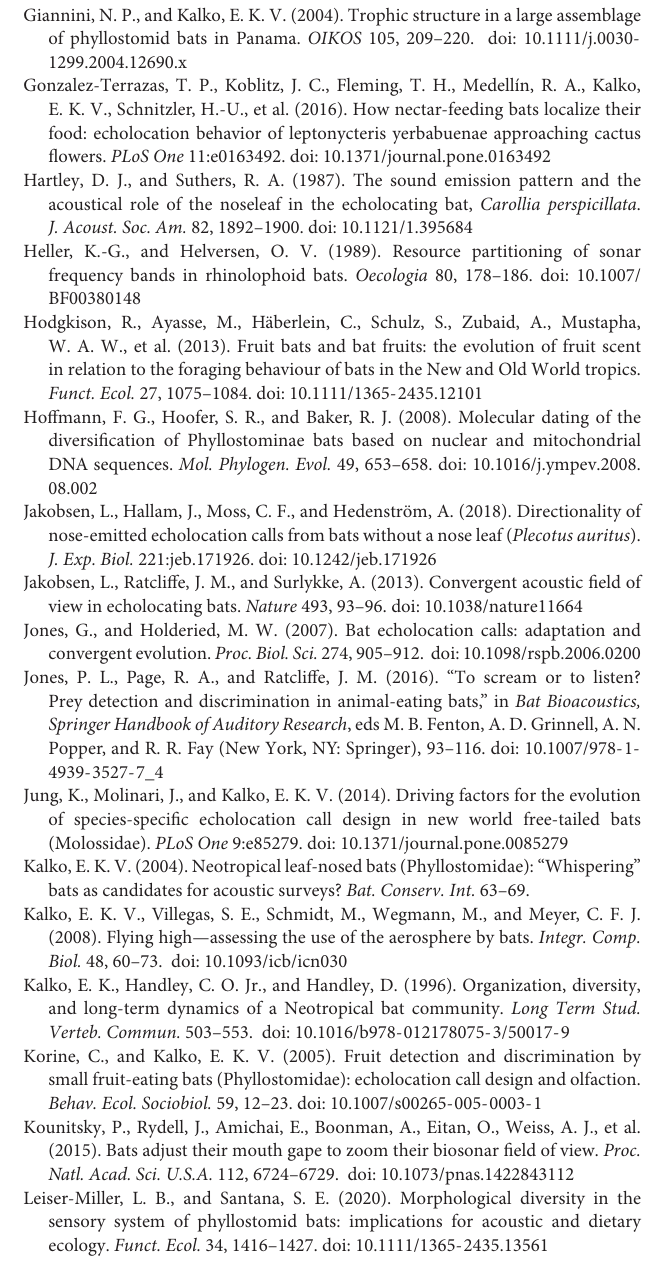
of the bat, infrared lights (IR) and high-speed cagmera (camera) located at ca. 30 cm at a 90 ◦ angle on a parallel line at ca. 40 cm distance to point of release. Supplementary Figure 2 | Schematic drawings illustrating the measured angles: (A) two axes were drawn along the upper (palate) and lower (dentary) jawbone and the gape angle measured in between; (B) a line along the main body axis was drawn and crossed with a second line drawn between the upper and lower jawbone (angle dissector of the gape angle) and the head position angle was measured. Supplementary Figure 3 | Examples of Lonchorhina aurita photographed during roost emergence. In 41 individuals no teeth were visible and their mouth posture was scored as closed (left). 34 individuals were scored with open mouths because teeth were clearly visible (right) (Photos by MT).